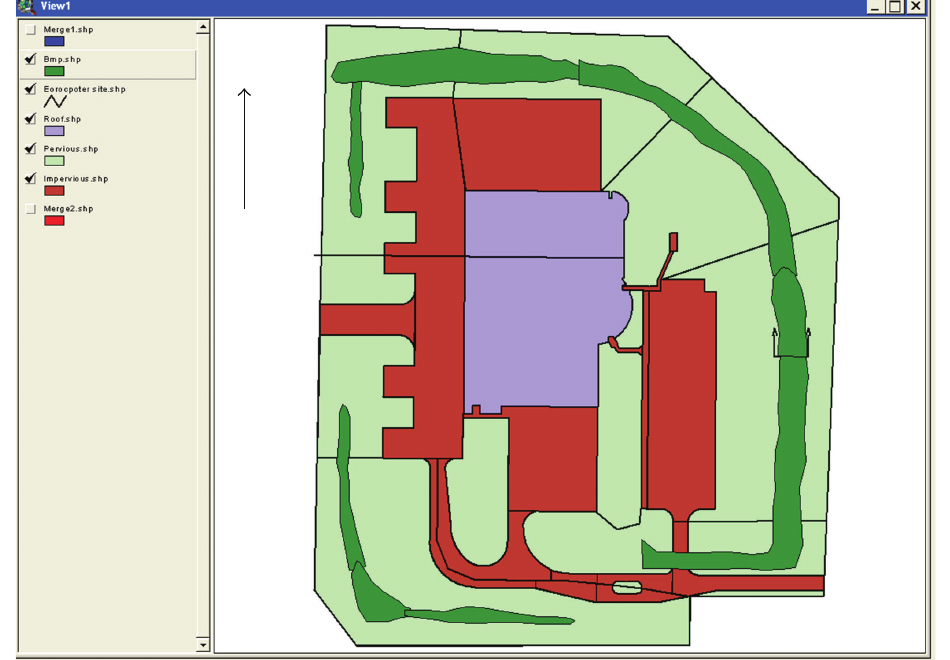
Figure 9: Eurocopter site in ArcView.